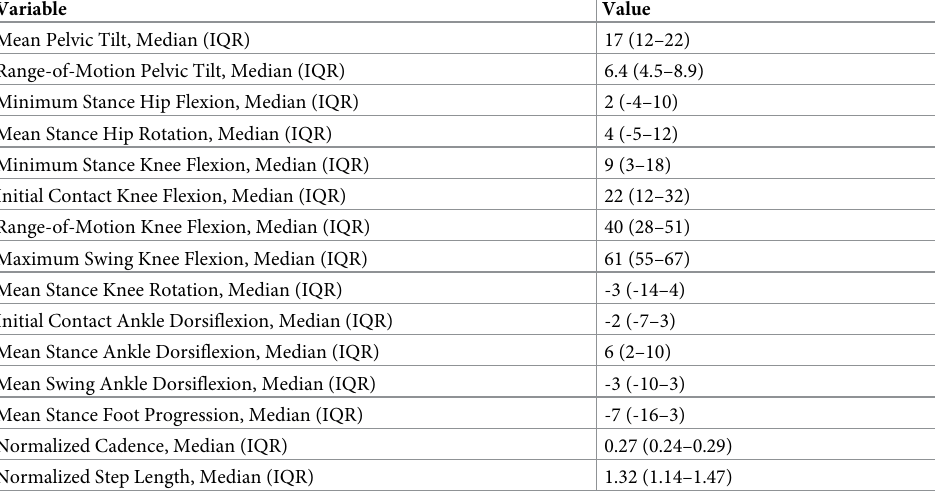
Table 4. Gait mechanics.